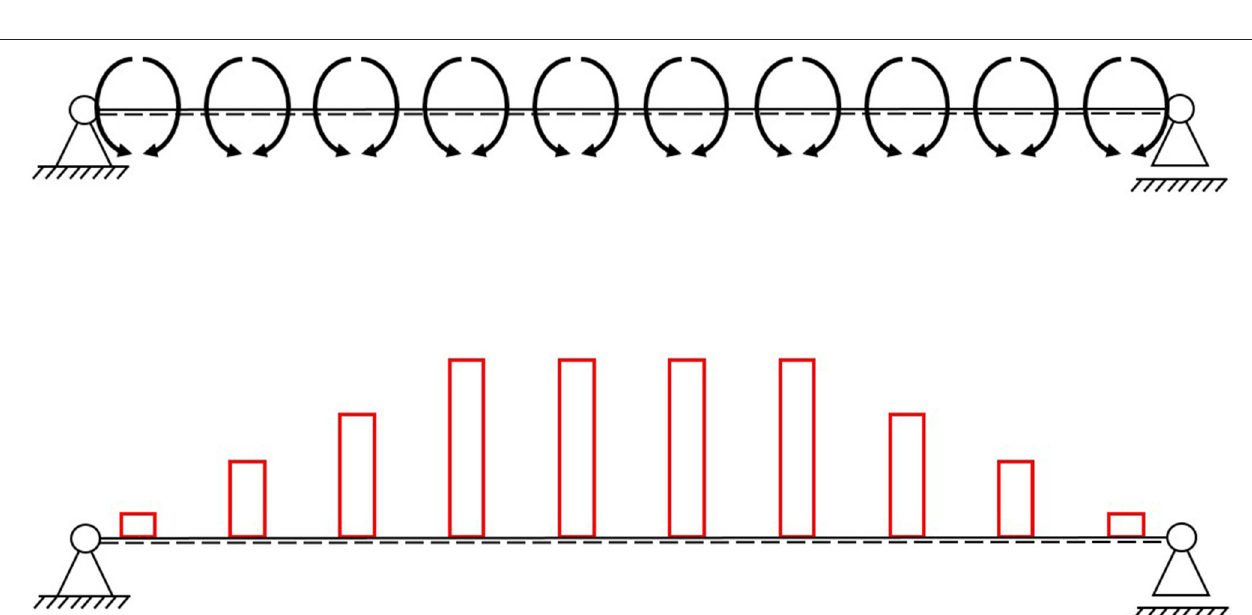
FIGURE 5 | Induced moments by 10 actuators (Top) and the bending moment diagram as a reaction to two symmetrical loads (Bottom)